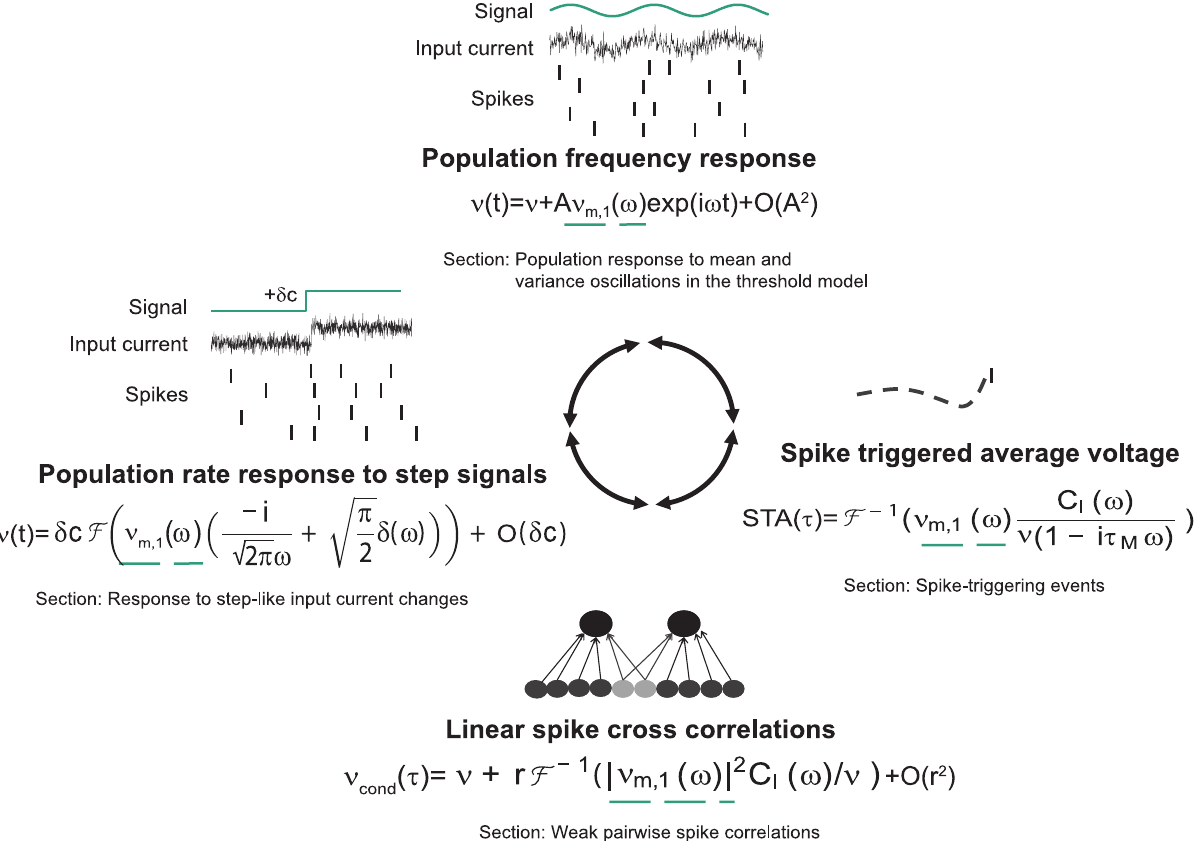
Figure 2. Computational role of mean-encoded signals. (Top) Representation of periodic mean stimuli in the population rate of noisy, independent neurons. (Left) Representation of step-like mean signals in the population rate of noisy, independent neurons. (Bottom) Common fluctuating currents from presynaptic partners represent a common mean signal that leads to pairwise spike correlation function n cond ( t ) . (Right) The average voltage before a spike is shaped by the linear mean response. C I ( v ) denotes the input current correlation function. The role of the linear response function n m ,1 ( v ) is indicated by a dashed green line. Results obtained in the alternative threshold model are discussed in the indicated Sections of this